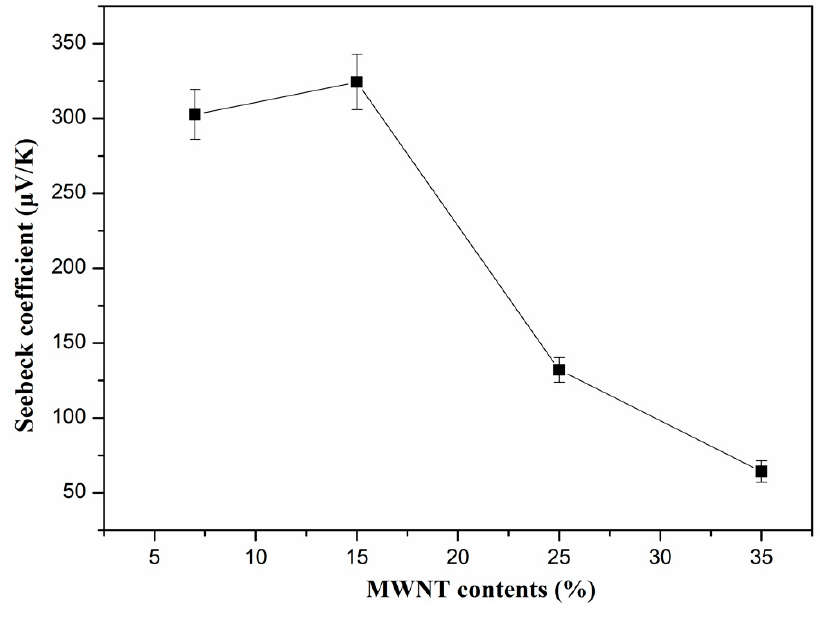
Figure 4. Seebeck coefficient of PVDF/MWNTs composites with different content of MWNTs at room temperature.